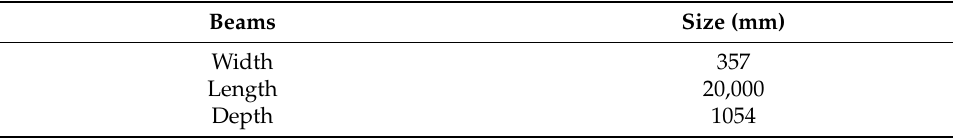
Table 2. Dimensions of the timber beams.